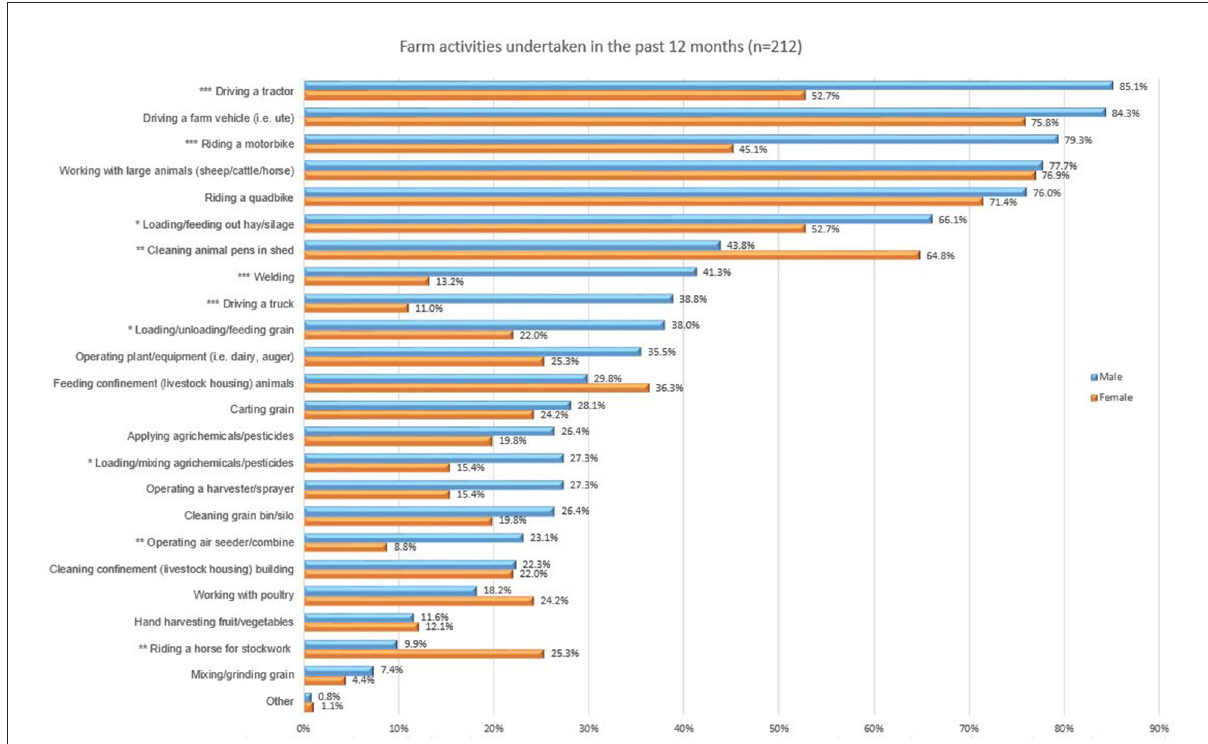
FIGURE3 Proportion of participants reporting common tasks undertaken in last 12 months. *Significant difference between males and females using a Two Sample Z -Test for Proportions where *** p ≤ 0.001, ** p ≤ 0.01, * p ≤ 0.05.